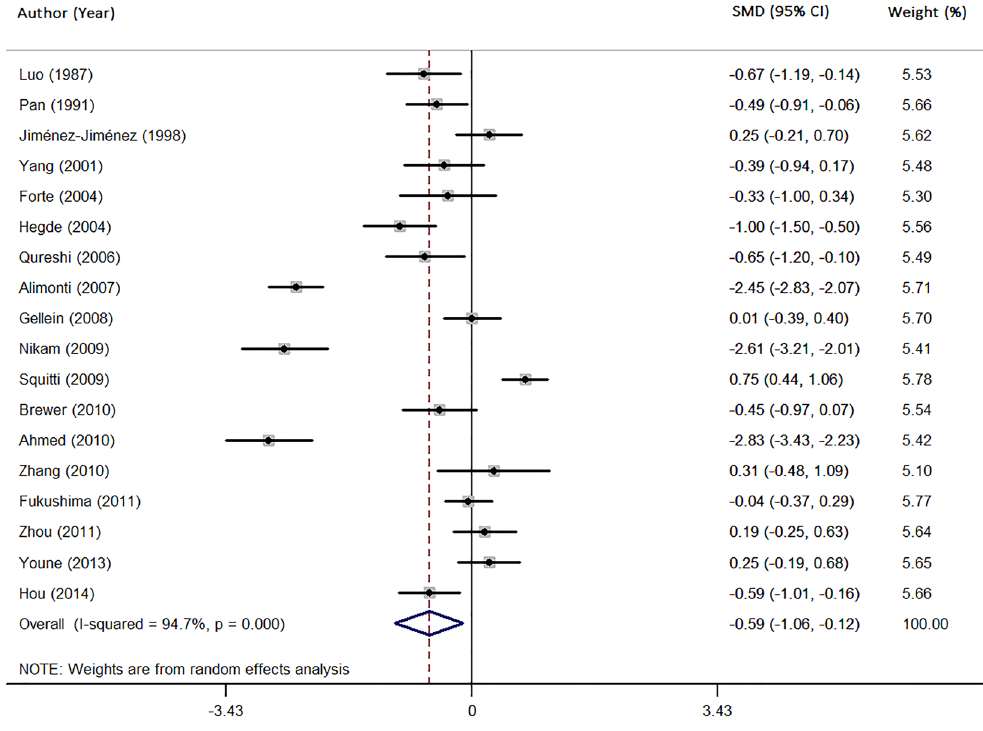
Figure 2. Forest plot for random-effects meta-analysis on differences in serum Zn between PD patients and health controls. 18 studies encompassing a sample of 1599 subjects. The horizontal lines represent 95% CI. The sizes of the shaded squares are proportional to study weight. SMD, Standardized mean difference; CI, confidence interval.